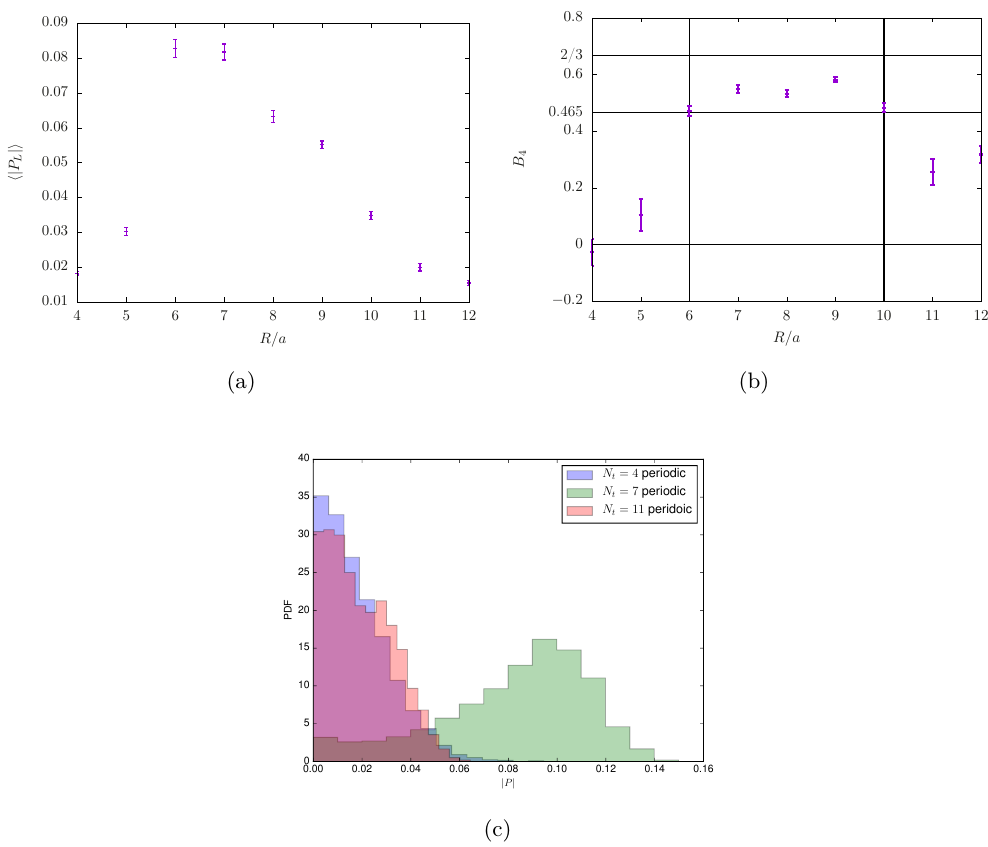
Figure 7 . Polyakov loop data from simulations of N f = 2 QCD(adj) at β = 1 . 75, κ = 0 . 1620 ( c sw = 1 . 0) with periodic boundary conditions. (a) The average modulus of the Polyakov loop as a function of R/a , (b) the Binder cumulant, (c) the histogram of | P L |